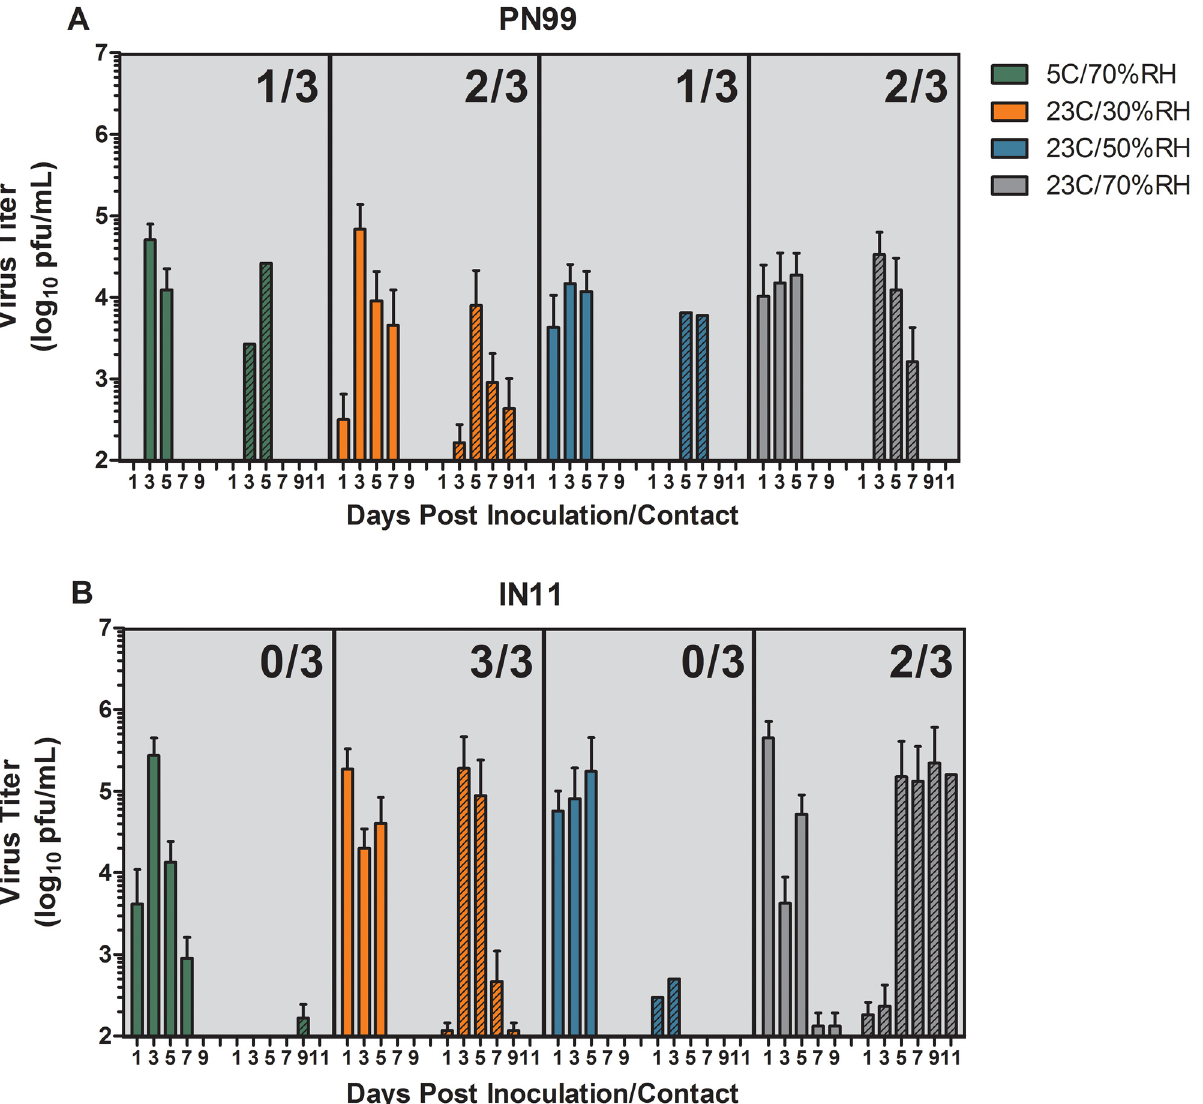
Fig 2. Respiratory droplet transmission of PN99 and IN11 influenza virus among ferrets. Three ferrets each were housed under the designated environmental conditions and were presented with 10 3.8 – 10 5.5 pfu of PN99 (A) or IN11 (B) virus by aerosol inhalation. One day later, a na ï ve, contact ferret was placed in a cage adjacent to each inoculated animal. Nasal washes were collected from ferrets every two days for up to 11 days and virus titers were assessed by plaque assay. Solid bars represent data from inoculated ferrets, n = 3, and hatched bars represent contact ferret data. The mean ± SD is shown and the limit of virus detection is 100pfu/mL. Frequency of transmission events is shown as an inset on each panel and represents the number of contact animals that shed virus and